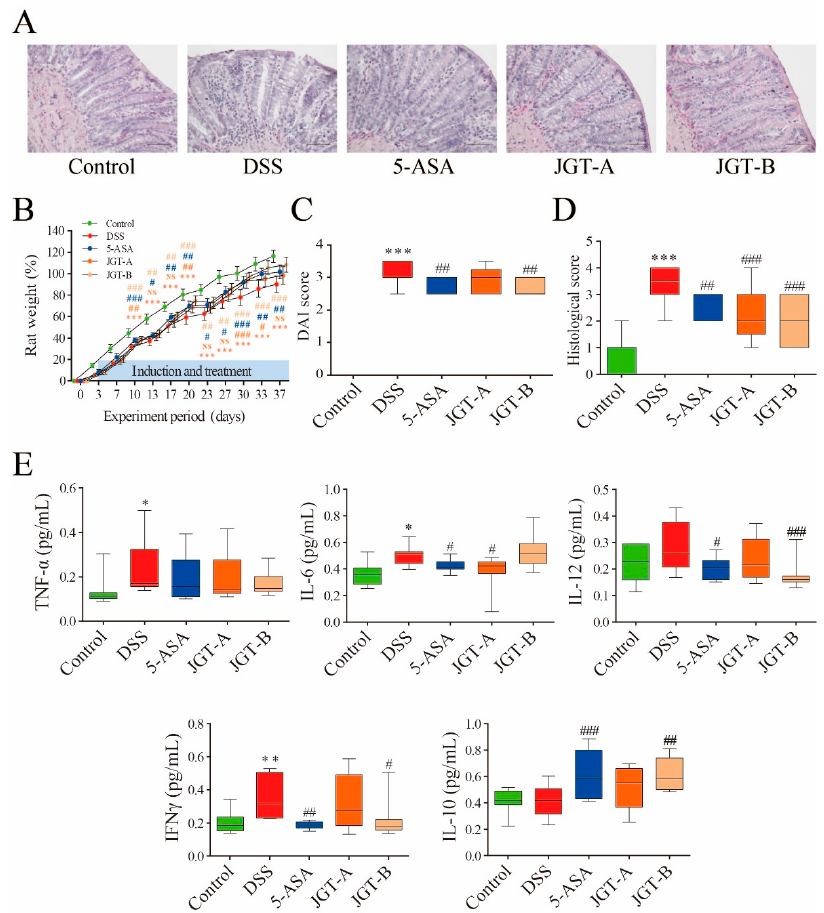
Figure 1. The effect of Jakyakgamcho-tang ( JGT) on inflammation of gut tissue in colitis rat. ( A ) Figure1. Theeffectof Jakyakgamcho-tang (JGT)oninflammationofguttissueincolitisrat. ( A )Representative Representative images by hemotoxylin and eosin ( HE) staining displaying colon segments on the day of imagesbyhemotoxylinandeosin(HE)stainingdisplayingcolonsegmentsonthedayofsacrifice.( B sacrifice. ( B ) Weight, ( C ) disease activity index (DAI) value, and ( D ) histological score. ( E ) Levels of TNF- α , IL-6, IL-10, IL-12, and IFN- γ . The statistical outcome was summarized within the figure ( t test: p value).